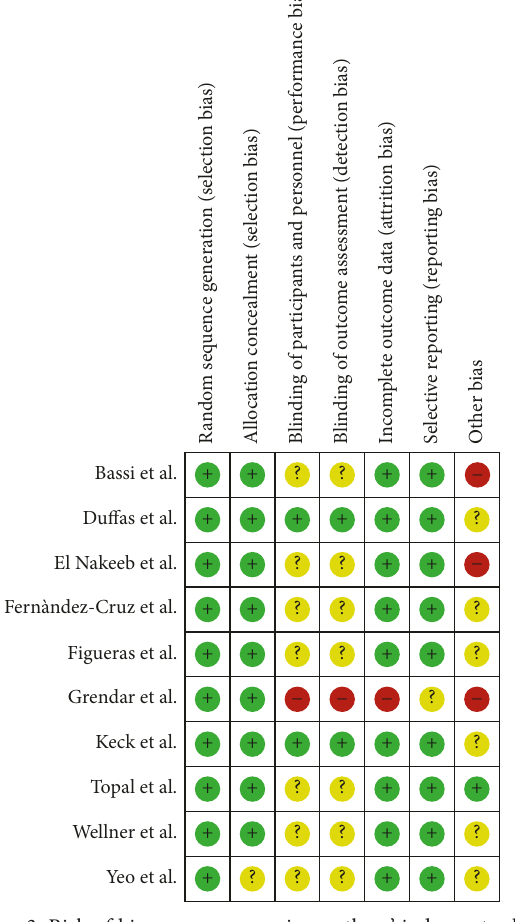
Figure 3: Risk of bias summary: review authors’ judgments about each risk of bias item for each included